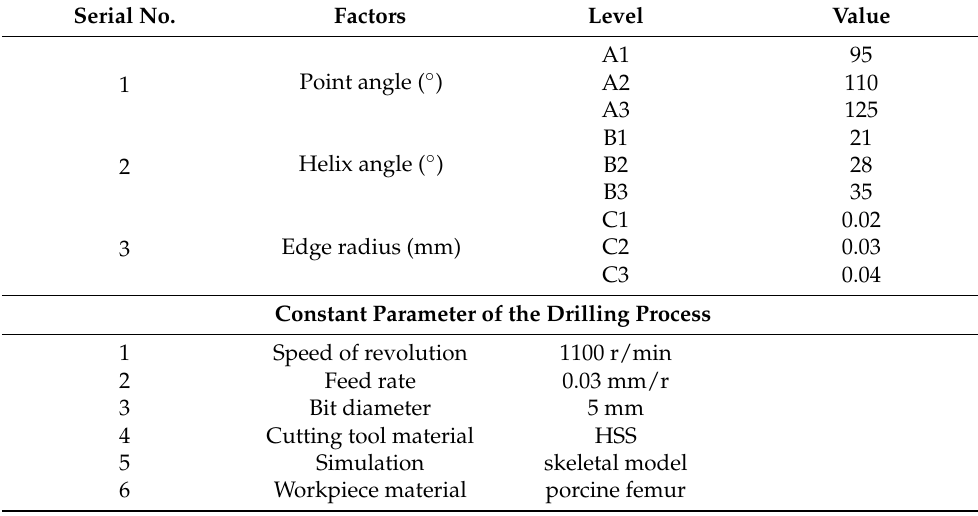
Table 3. Levels of parameters used in